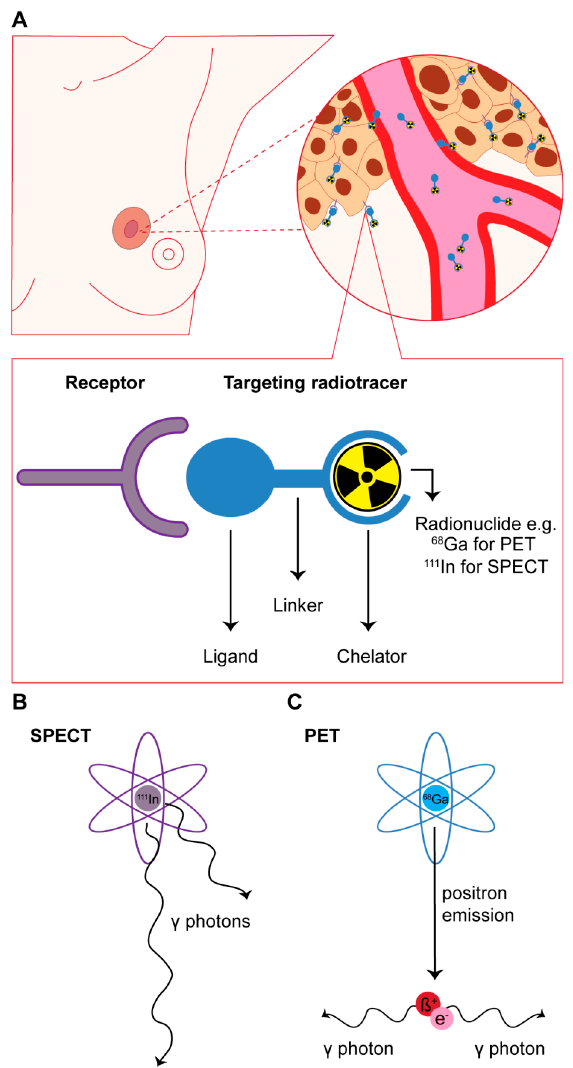
Figure 1. ( A ) Schematic overview of receptor targeted nuclear imaging. Ligands that can bind their targets overexpressed on breast cancer (BC) cells can be coupled to a chelator, often via a linker. The chelator enables labeling with radionuclides such as 68 Ga and 111 In that can be applied for imaging purposes; ( B , C ) drawing of the principles of radionuclides for single-photon emission computed tomography (SPECT) and positron emission tomography (PET) imaging. For SPECT imaging, γ -photons from radionuclides such as 111 In are captured by detectors at multiple positions around the longitudinal axis of the patient. For PET imaging positrons emitted from a radionuclide such as 68 Ga interact with electrons which results in the production of 2 γ -photons. These photons are picked up by opposing detectors installed in a ring-like pattern.